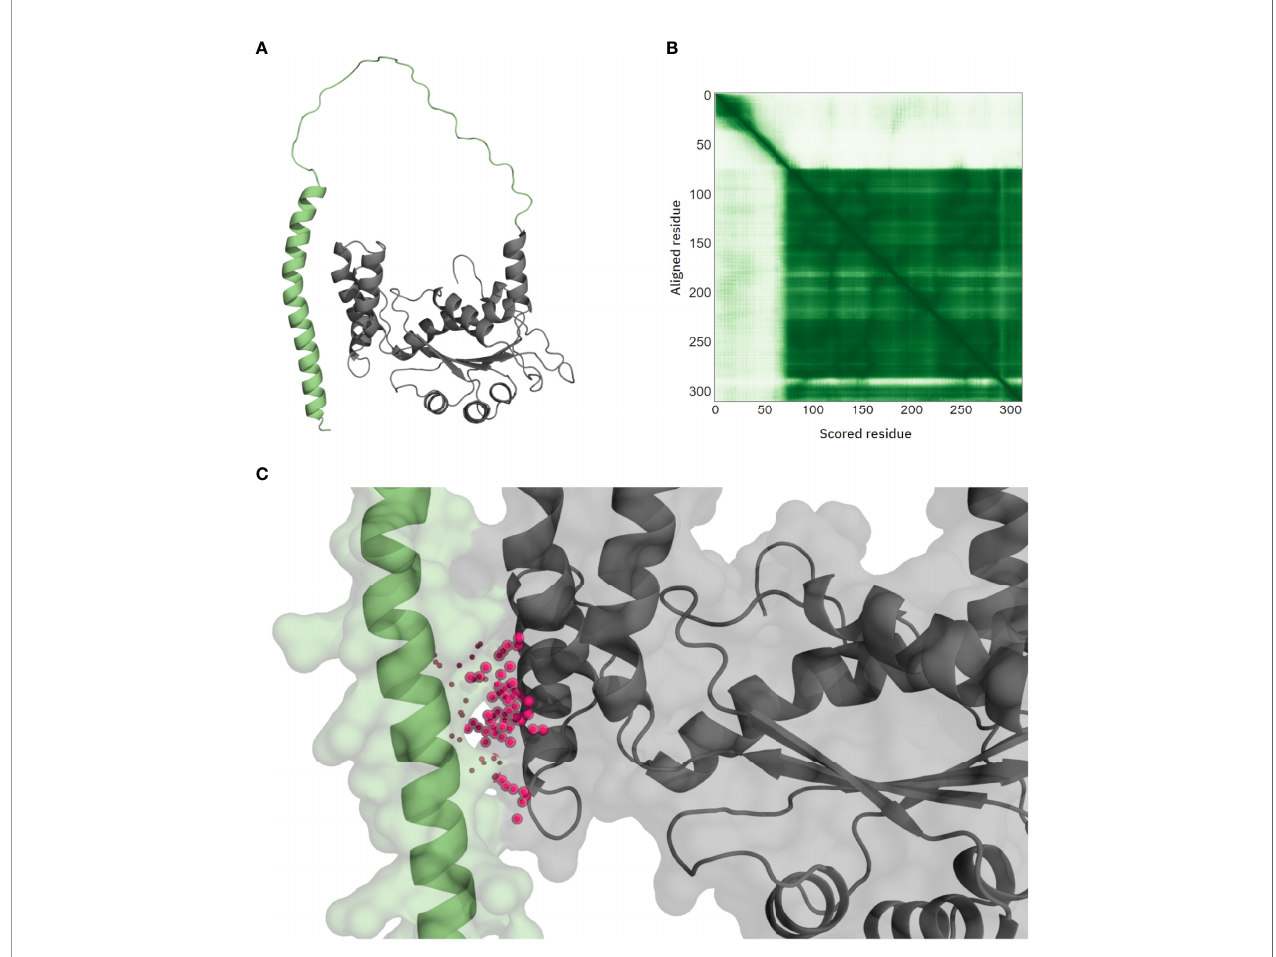
FIGURE 4 | T. cruzi nitroreductase AlphaFold model. The relative position of the N-terminal domain ( A , green residues) compared with the rest of the protein has very low con fi dence, as seen in the Predicted Aligned Error (PAE) plot (B) . The predicted pocket by P2Rank falls in the interaction between this domain and the rest of the protein ( C , purple spheres), suggesting that this pocket might be an